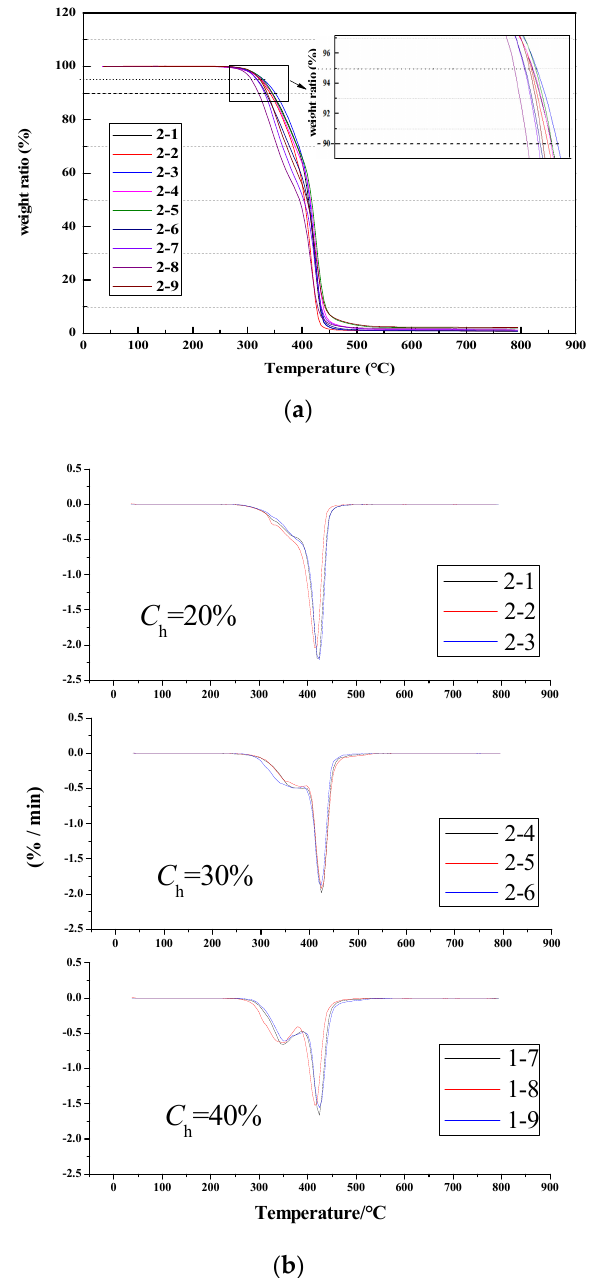
Figure 14. TGA and DTA curves of polyether-based TPUs. ( a ) TGA; ( b ) DTA.